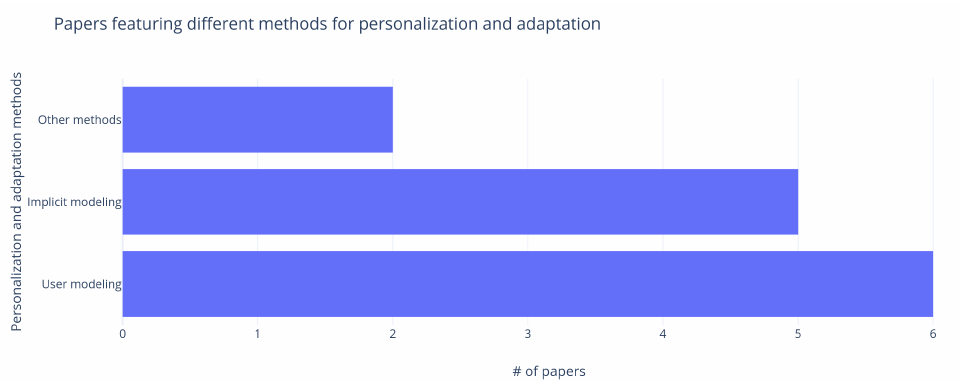
Figure 5. Papers featuring different methods for personalization and adaptation. Implicit modeling represents language understanding and generation methods, as ICAs personalize output by, e.g., recognizing emotions in the